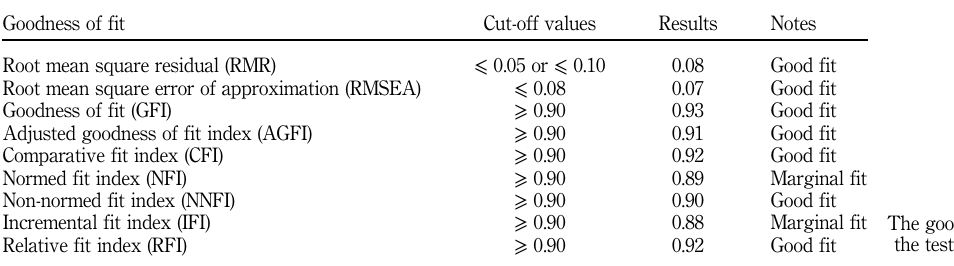
Table 3. The goodness of fit